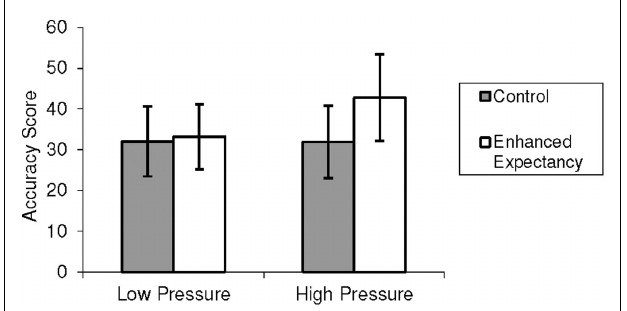
FIGURE 1 |Accuracy scores of the control and enhanced-expectancy groups in the low-pressure (Block 1) and high-pressure conditions (Block 2). (Error bars represent